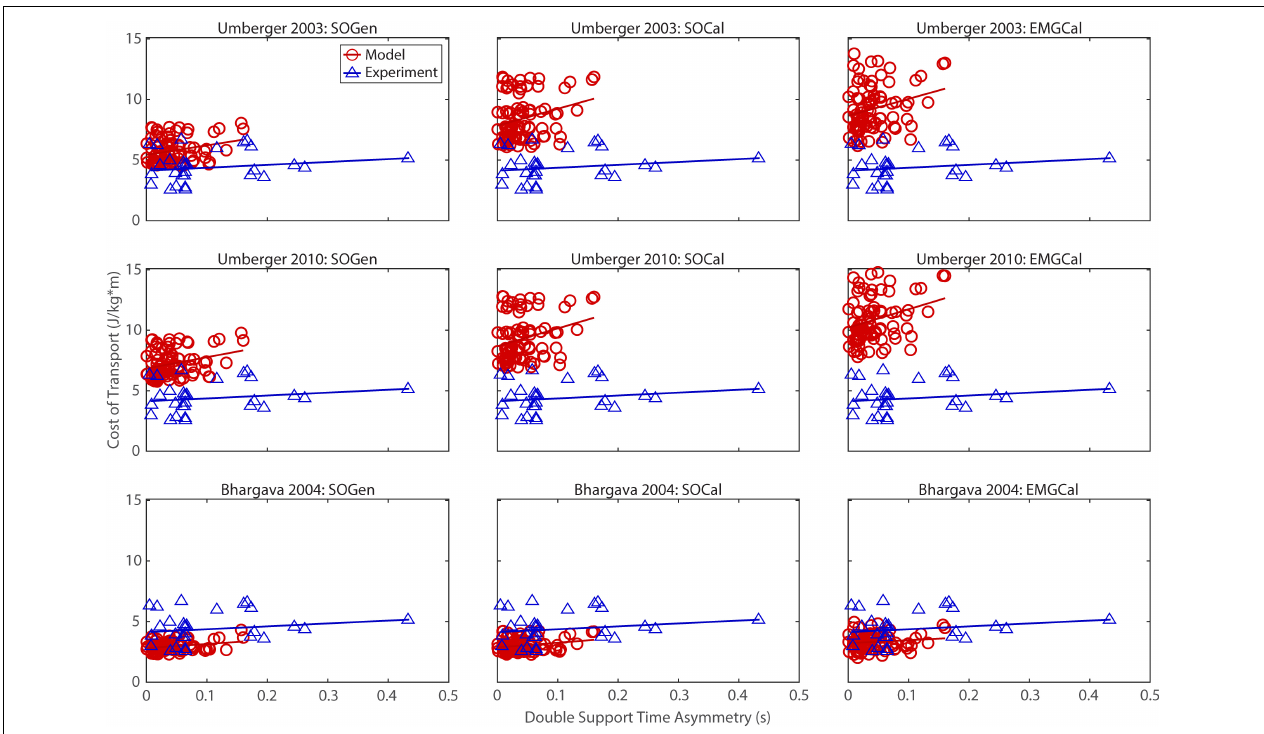
FIGURE 5 | Comparison of model predicted (red circles) and experimentally measured (blue triangles) cost of transport as a function of double support time asymmetry between paretic and non-paretic legs. See Figure 2 caption for additional details.